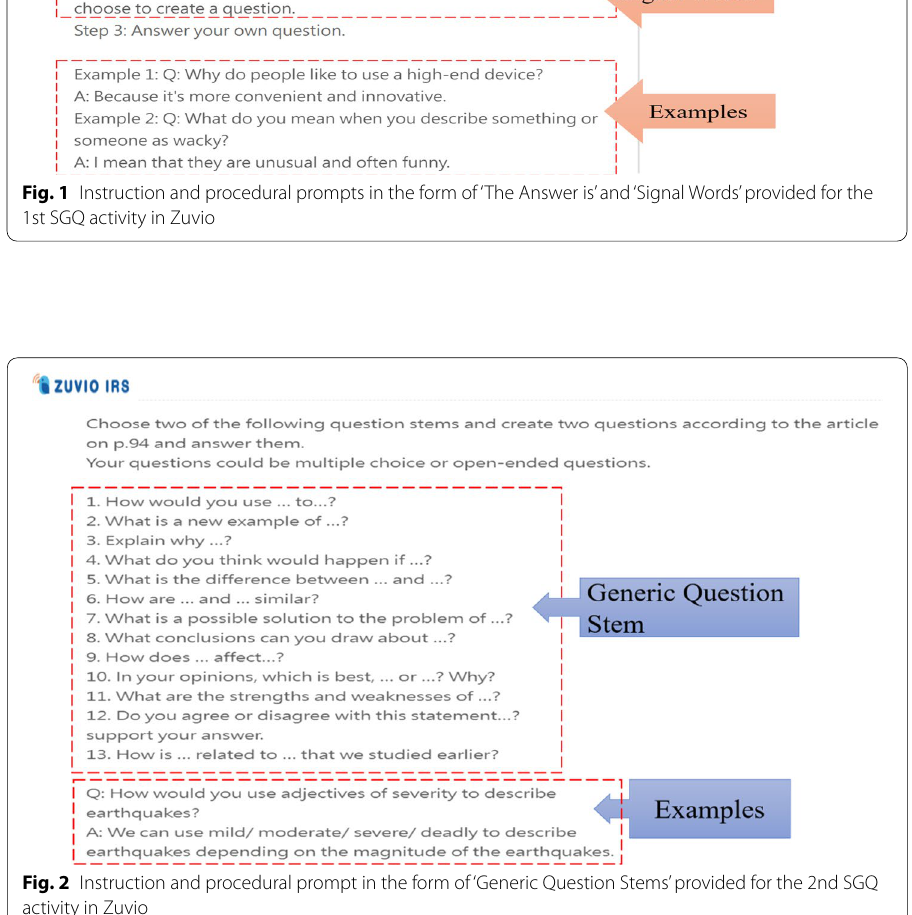
Fig. 2 Instruction and procedural prompt in the form of ‘Generic Question Stems’ provided for the 2nd SGQ activity in Zuvio